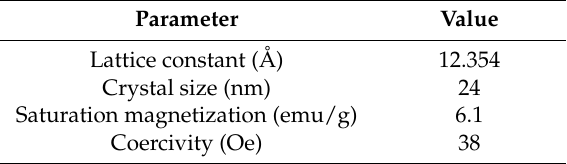
Table 1. Microstructural and magnetic properties of the yttrium iron garnet (YIG) sample